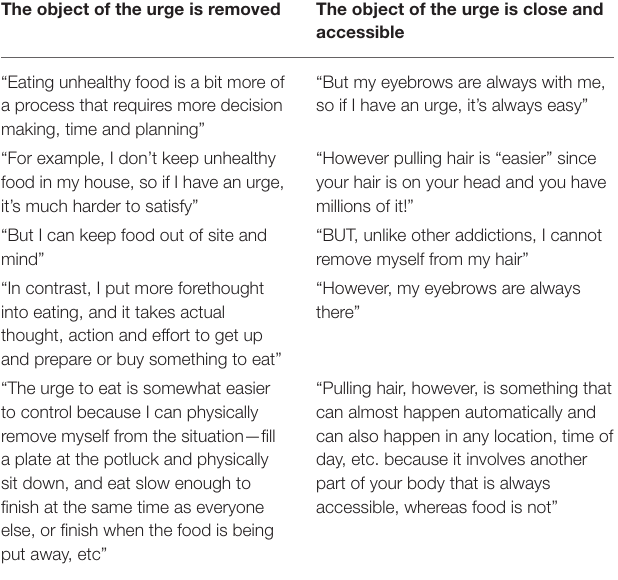
TABLE 4 | Examples of participant comments on whether the object of the urge (to eat an unhealthy food or pull hair) is removed, or close and accessible.